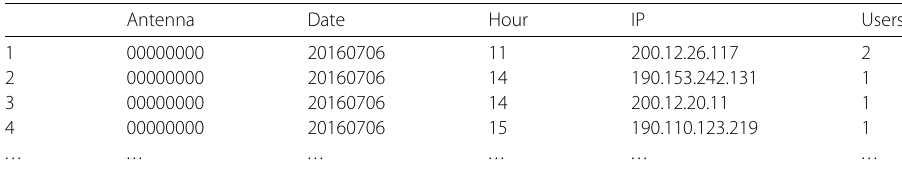
Table 1 The first lines of the DPI dataset Antenna